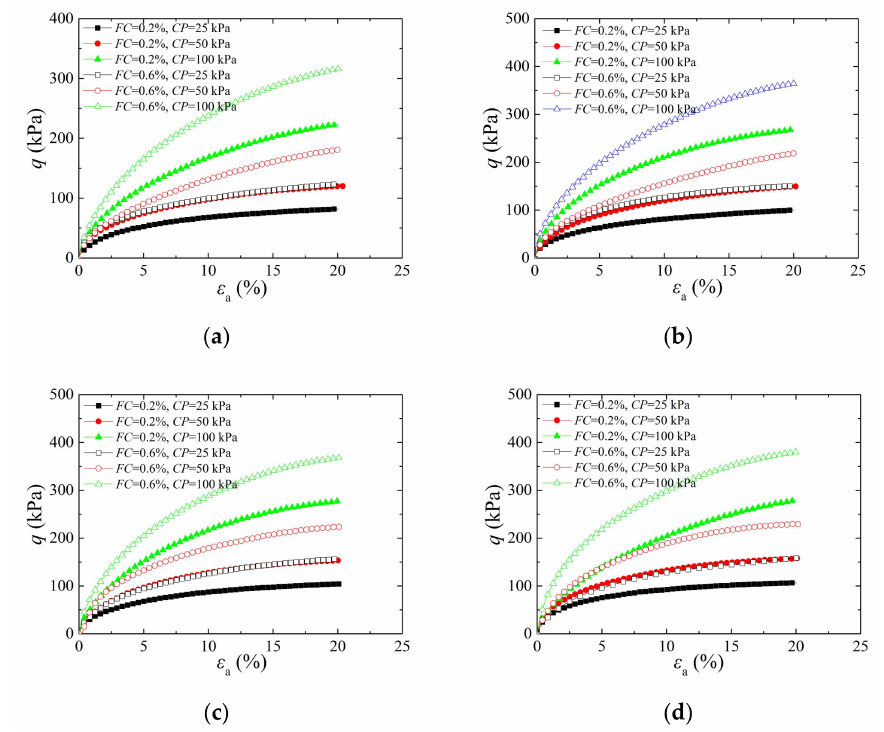
Figure 5. Effect of cell pressure on stress–strain curves: ( a ) FL = 4 mm; ( b ) FL = 8 mm; ( c ) FL = 12 mm; ( d ) FL = 16